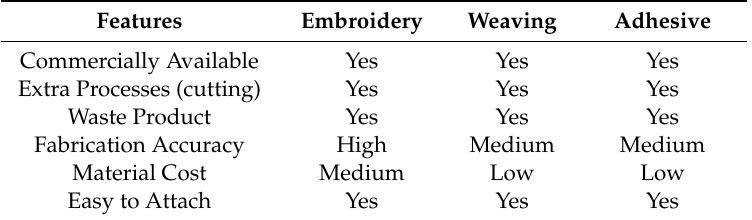
Table 7. Comparison of fabric and adhesive techniques